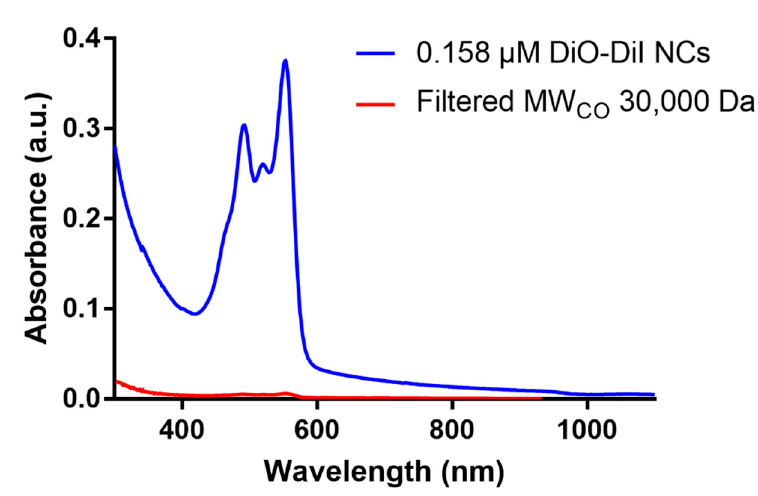
Figure A1. Absorbance scan of a 1:100 dilution of DiO-DiI NCs before (blue line) and after filtration (red line) through a 30,000 Da filter membrane for 10 min at 4000 × g .